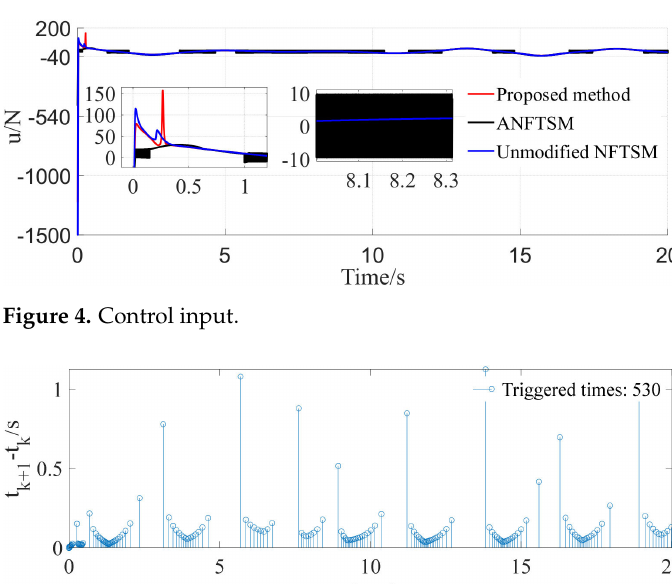
Figure 3. Tracking error.